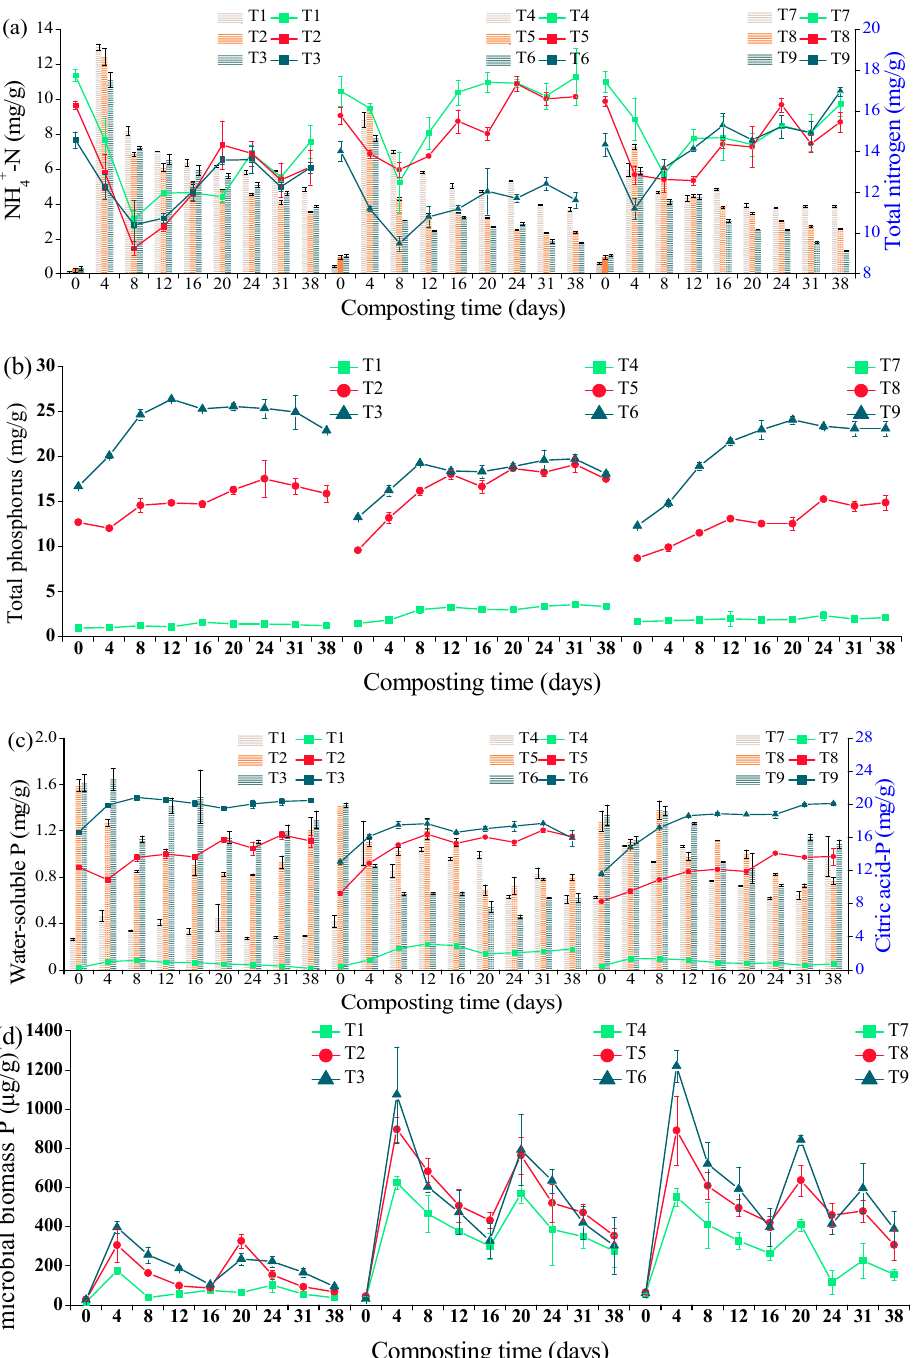
Figure 2. Temporal variation in NH 4+ –N content and total Kjeldahl nitrogen content ( a ), water-soluble P and citric acid-P ( c ) during the composting process (bar diagram is represented by primary y -axis and line diagram by secondary y -axis (blue)). Variation in total phosphorus content ( b ) and microbial biomass P ( d ) during the composting process. Treatments T1–T9 are described in Table 1. Citric acid-P is insoluble or slightly soluble in water, but plants can dissolve and absorb it through organic acids secreted by roots [44]. Changes in citric acid-P concentration (Figure 2c) was